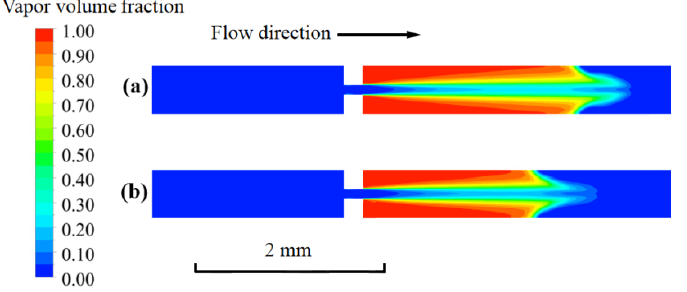
Figure 5. The comparison of vapor-liquid distribution with the experimental observation [31].